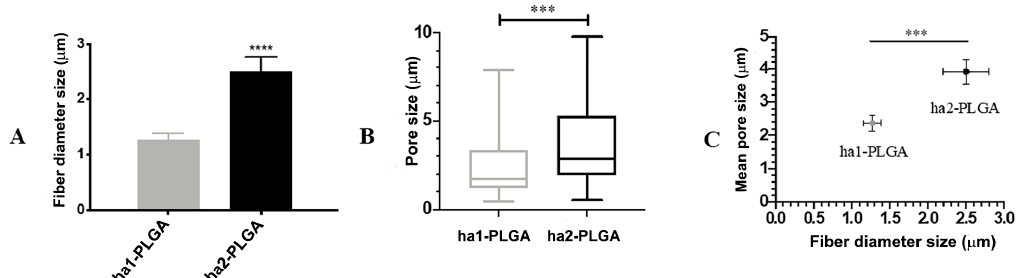
Figure 2. Fibers’ diameter and pore sizes of the ha1- and ha2-PLGA microfibers. ( A ) Histogram showing that ha1-PLGA microfibers have a diameter size of 1.27 ± 0.11 µ m (ha1-PLGA) while ha2-PLGA 2.5 ± 0.27 µ m. *** and **** Statistically significant values between ha1-PLGA and ha2-PLGA fleeces ( p < 0.001 and p < 0.0001, respectively). ( B ) Frequency distribution of pore size within PLGA fleeces in which the mean pore sizes were 2.37 ± 0.24 µ m for ha1-PLGA and 3.92 ± 0.39 µ m for ha2-PLGA. ( C ) Comparison showing that increasing fiber diameter size of ha-PLGA fleeces is accompanied by a significant increase in pore size ( p < 0.0001) (n = 3 for each type of